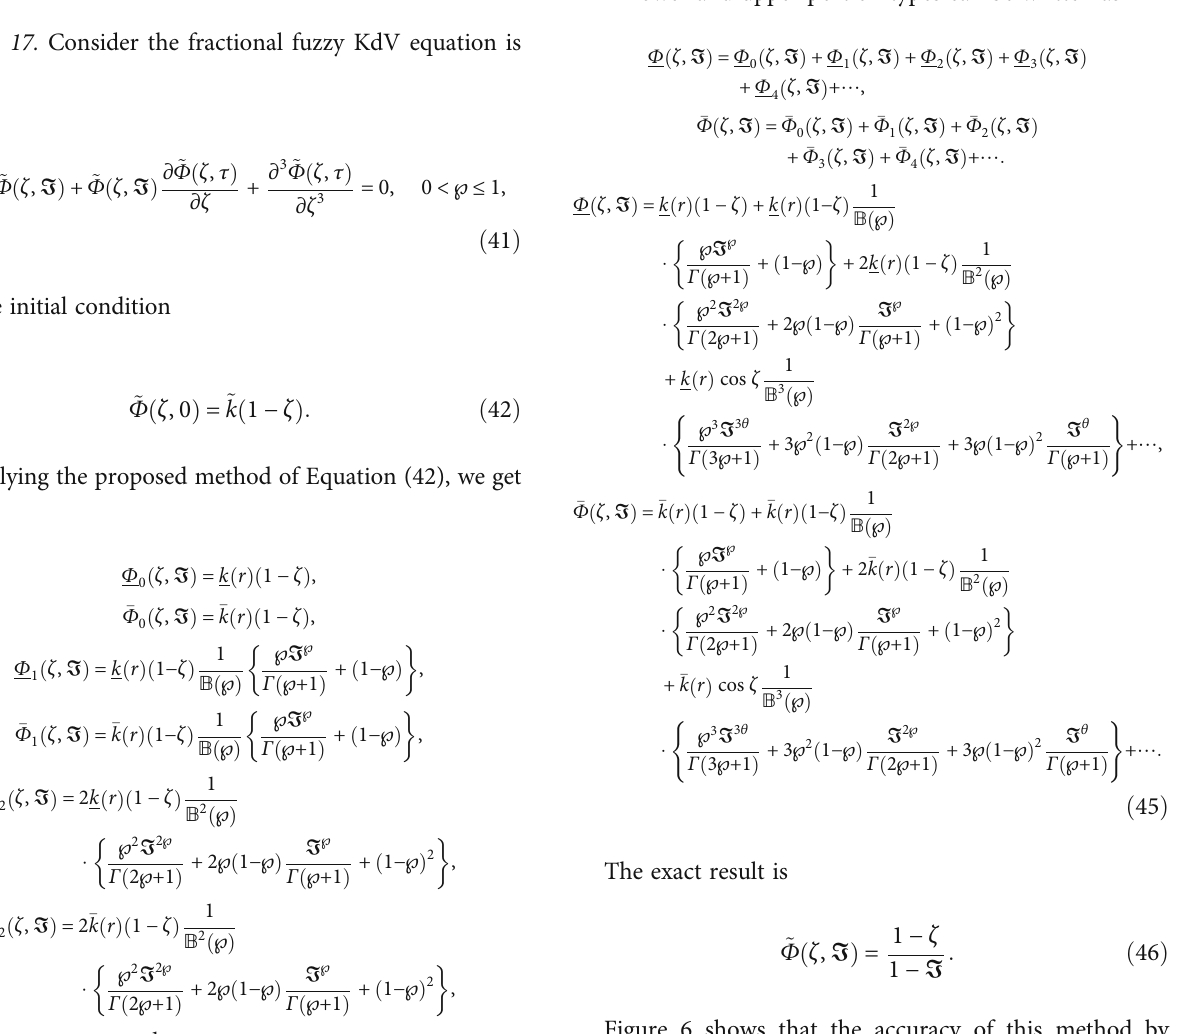
Figure 5 the approximate solution graph of fuzzy upper and lower branches and the 2nd fi gure is the various frac- tional order of ℘ with respect to time. The behaviour ~ Φ ð ζ , I Þ on the space de fi nes the variance in the mappings coordinate ξ with the consider of I and the unpredictabil- ity parameters r ε ½ 0, 1 (cid:2) . The graph shows that, as the pas- ~ Φ ð ζ , I Þ will become much sage of time, the mappings